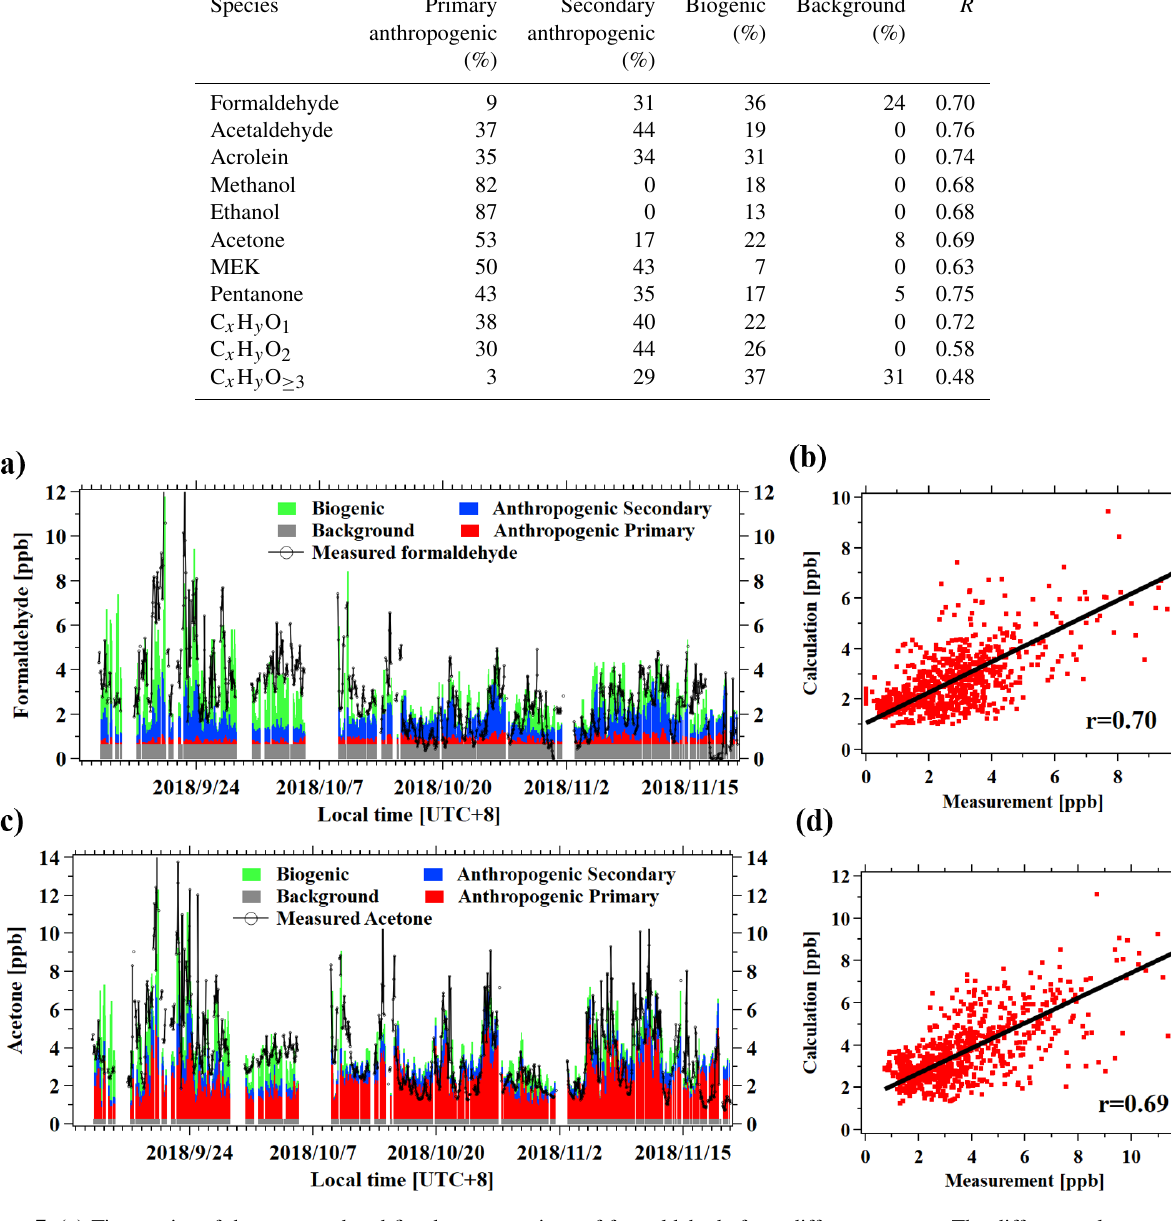
Figure 7. (a) Time series of the measured and fitted concentrations of formaldehyde from different sources. The different colors represent the four different terms of Eq. (1). (b) Scatterplot of the calculated versus the measured formaldehyde concentrations. (c) Time series of the measured and fitted concentrations of acetone from different sources. (d) Scatterplot of the calculated versus the measured acetone